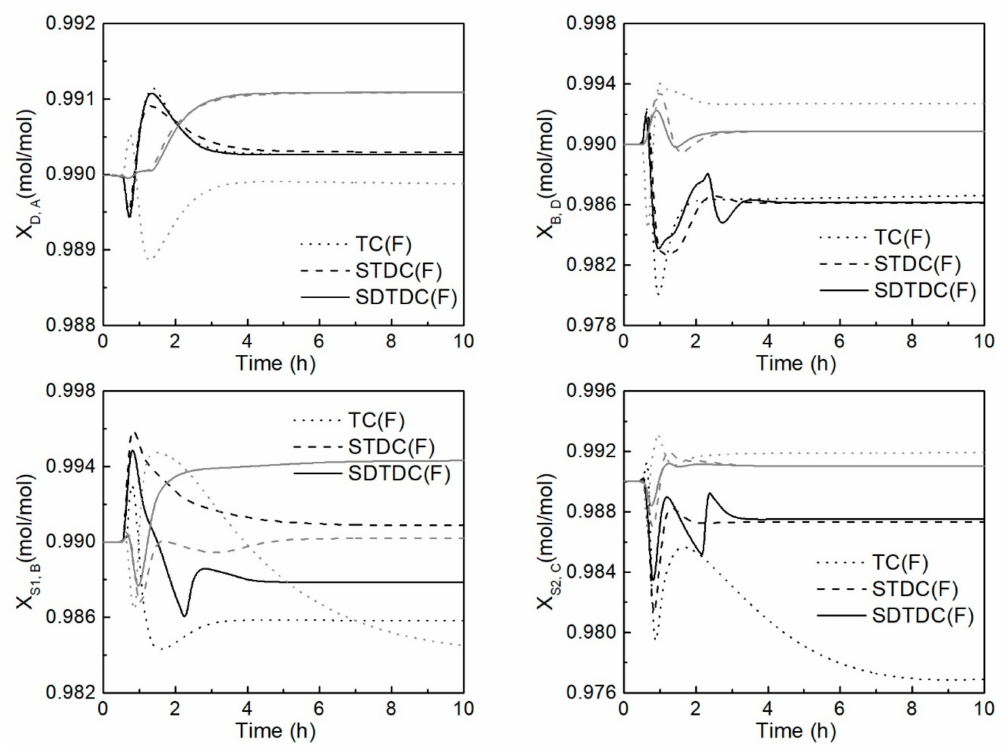
Figure 11. Dynamic responses in face of ± 10% feed flow